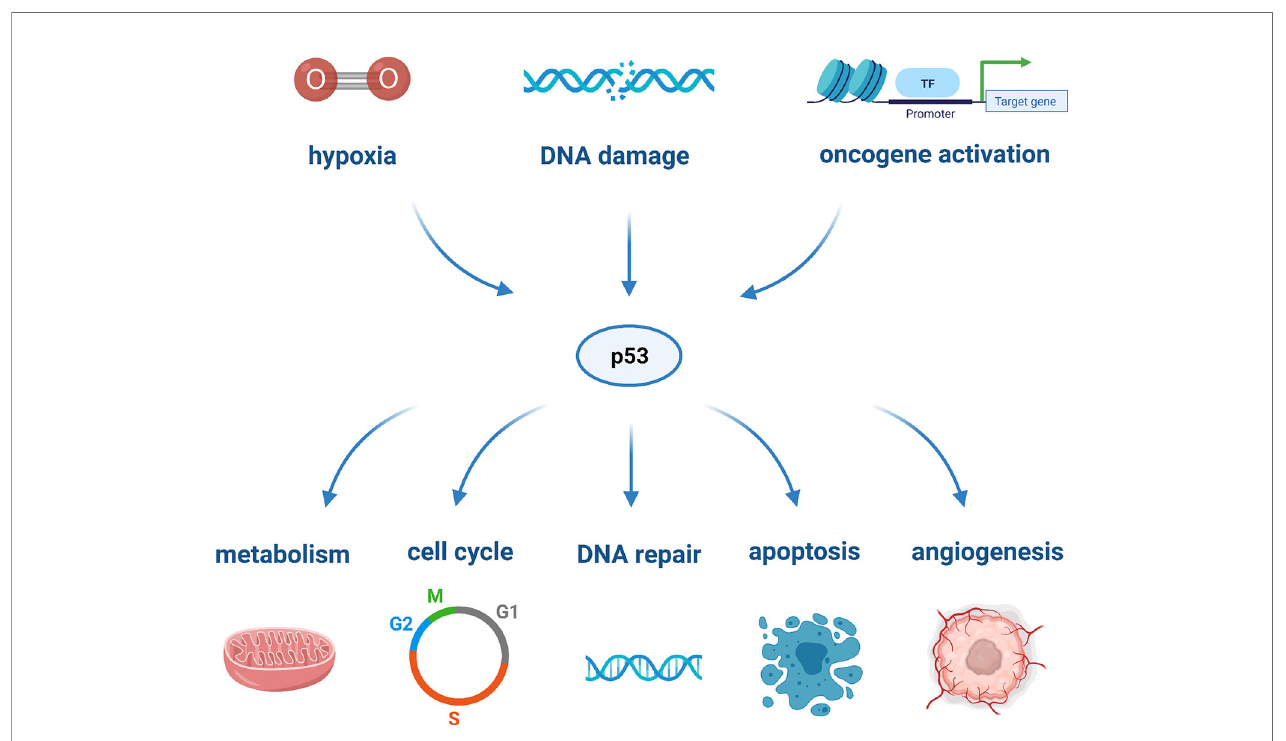
FIGURE 1 | The various cellular processes regulated by p53 in response to cellular